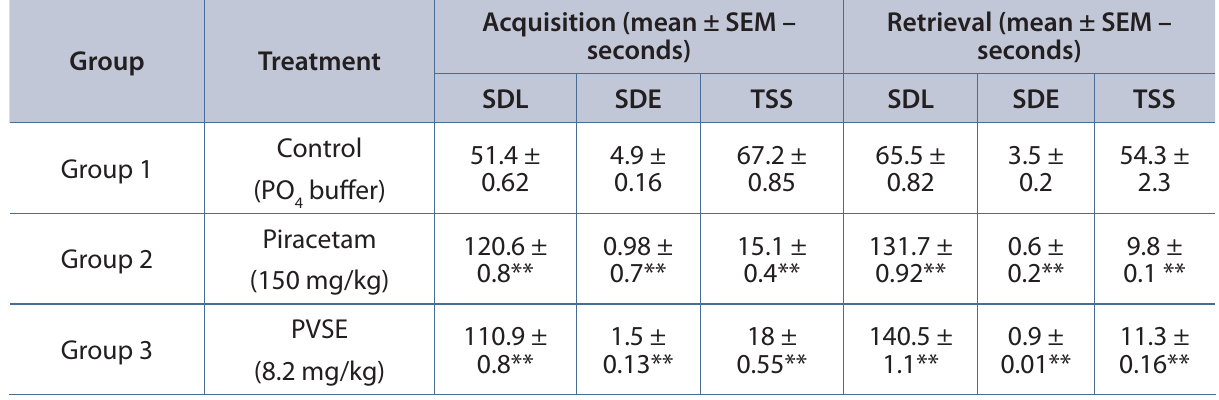
Table 3. Effect of piracetam and photooxidized Vespa orientalis venom protein on passive avoidance